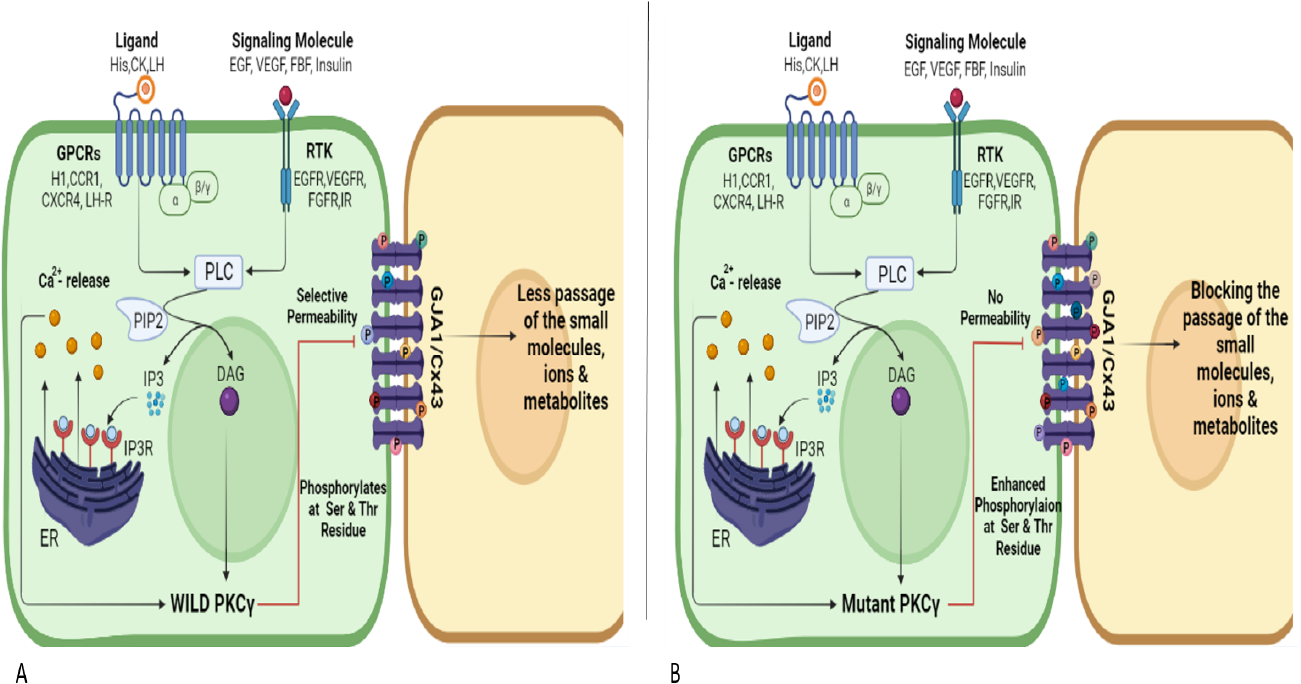
Figure 4. PKC γ regulating gap junctions: ( A ) Wild PKC γ causing semi-permeability through con- Figure 4 . PKCγ regulating gap junctions: ( A ) Wild PKCγ causing semi-permeability through nexin 43 gap junction; ( B ) Mutant PKC γ completely closing the connexin 43 gap connexin 43 gap junction; ( B ) Mutant PKCγ completely closing the connexin 43 gap junction .